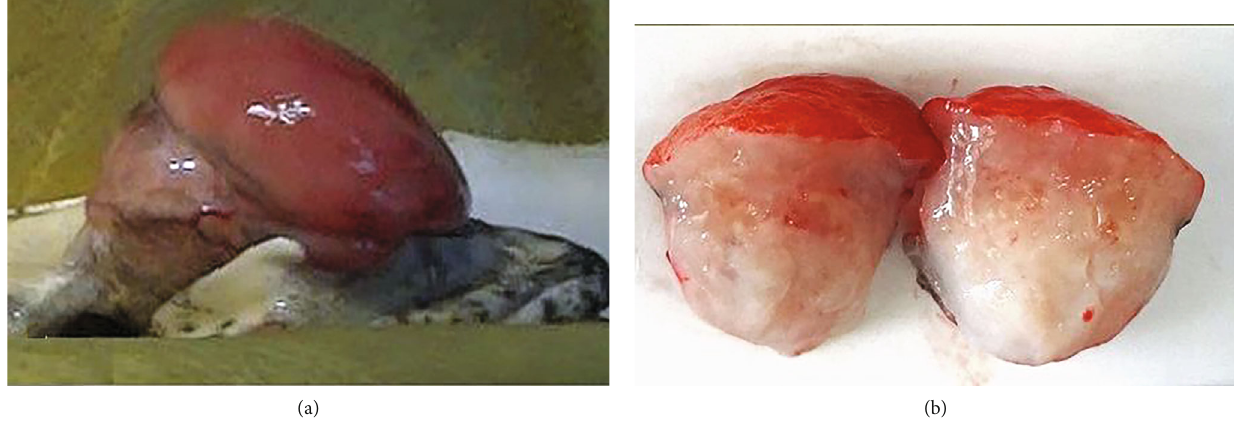
Figure 3: Mass in the gular region of a saddled bichir ( Polypterus endlicheri endlicheri ). (a) Gular mass immediately prior to surgical excision. The mass is seen to be emerging from tissue deep to the axial margins of gular plates, pushing the plate margins abaxially. (b) Cut surface of excised gular mass revealing its moist appearance, white colour and moderately fi rm